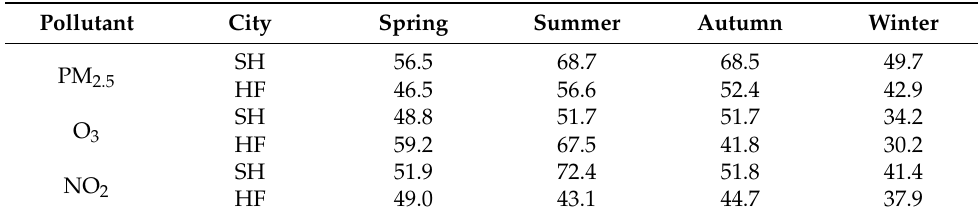
Table 3. Explained variance of six meteorological parameters upon the daily variability of PM 2.5 , O 3 , and NO 2 in different seasons in Shanghai (SH) and Hefei (HF) (unit: %). Pollutant City Spring Summer Autumn Winter PM 2.5